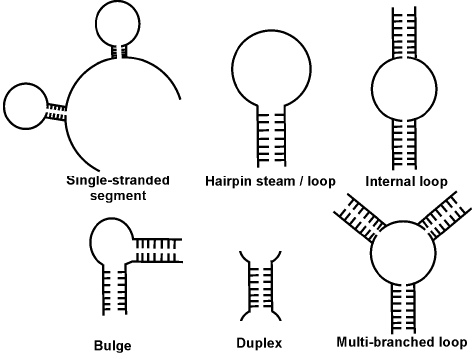
Figure 4. Pinhole structure of aptamers. Table 3. The structure of the DNA aptamers selective toward mycotoxins (see also Section 3).